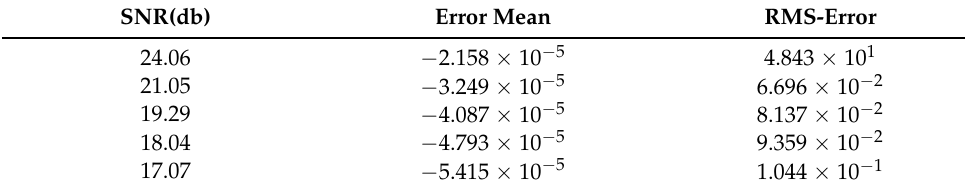
Figure 5. Tracking of the input signal and error by the observers after adding white noise. ( a ) Tracking of the input signal and ( b ) error. Table 1. Error at different